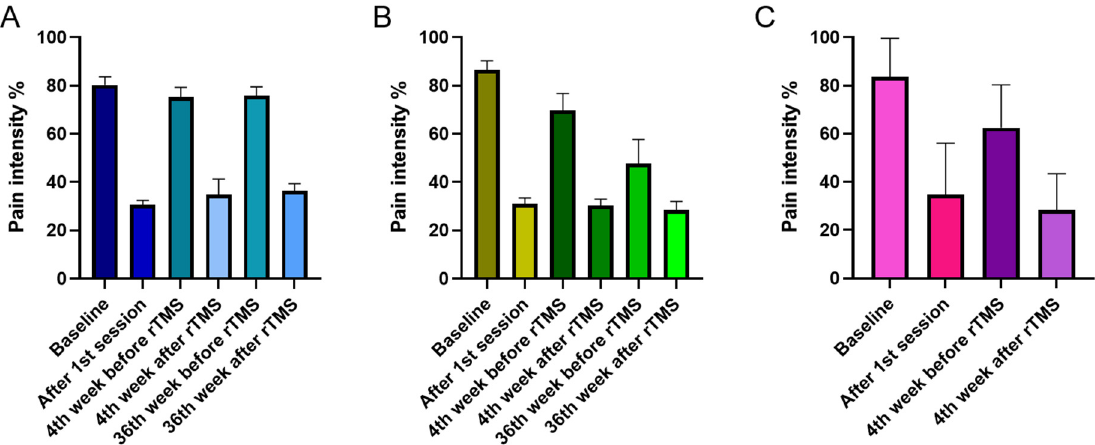
Figure 3. rTMS effects on pain intensity in the M1 ( A ), DLPFC ( B ), and sham group ( C ). The y-axis indicated the mean pain intensity expressed as a percentage (%). The x-axis indicates the time points (in weeks) of conducted measurements. Error bars depict the standard error of mean (SEM).